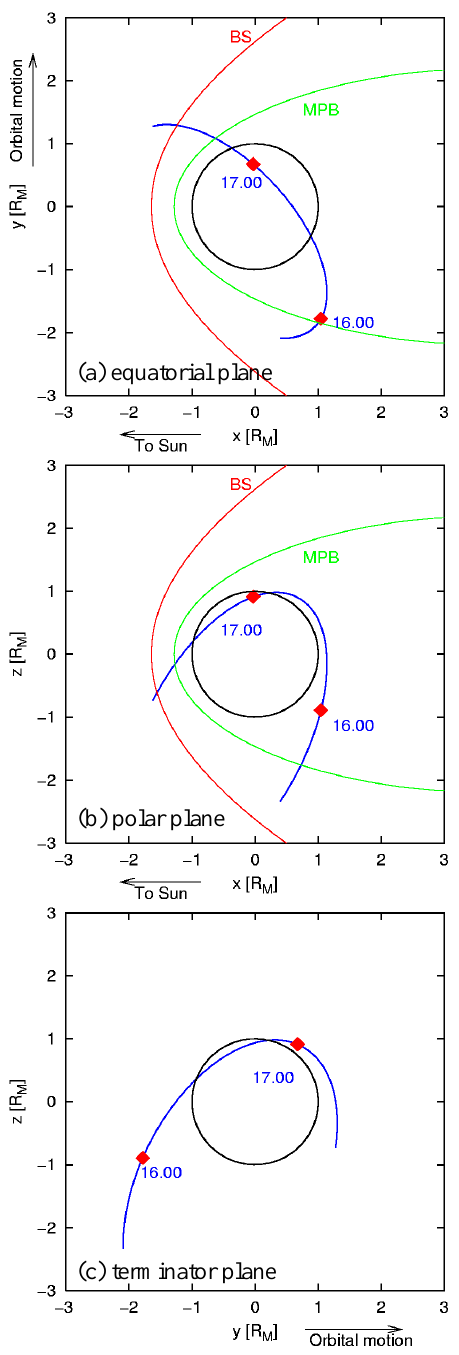
Fig. 1. Pojections of the trajectory of Mars Express orbit No. 1614 on the coordinates planes of our 3-D hybrid simulation. The undis- turbed solar wind flows in positive x-direction, the interplanetary magnetic field points in positive y-direction. The convective elec- tric field points to the negative z-direction. The orbital plane is tilted predominatly to the polar (x-z plane). The spacecraft cross the bow shock at 15:25 UT and again at 17:25